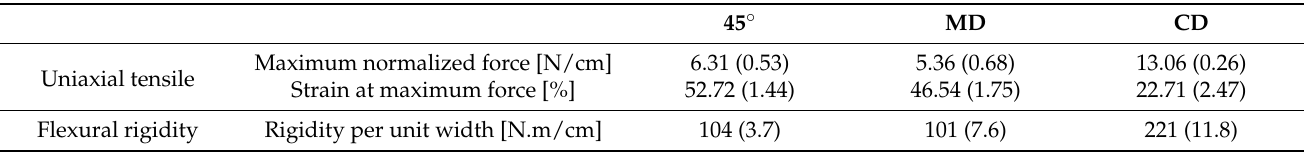
Figure 8. Normalised force–strain curve issued from tensile test of dry nonwoven material executed in three directions (45°, MD, CD) ( a ), and tangent modulus of unidirectional extension in the three directions ( b ). Table 1. Mean values of uniaxial tensile properties and flexural rigidity of the nonwoven in three direction MD, CD, and 45°; standard deviations are given in brackets.